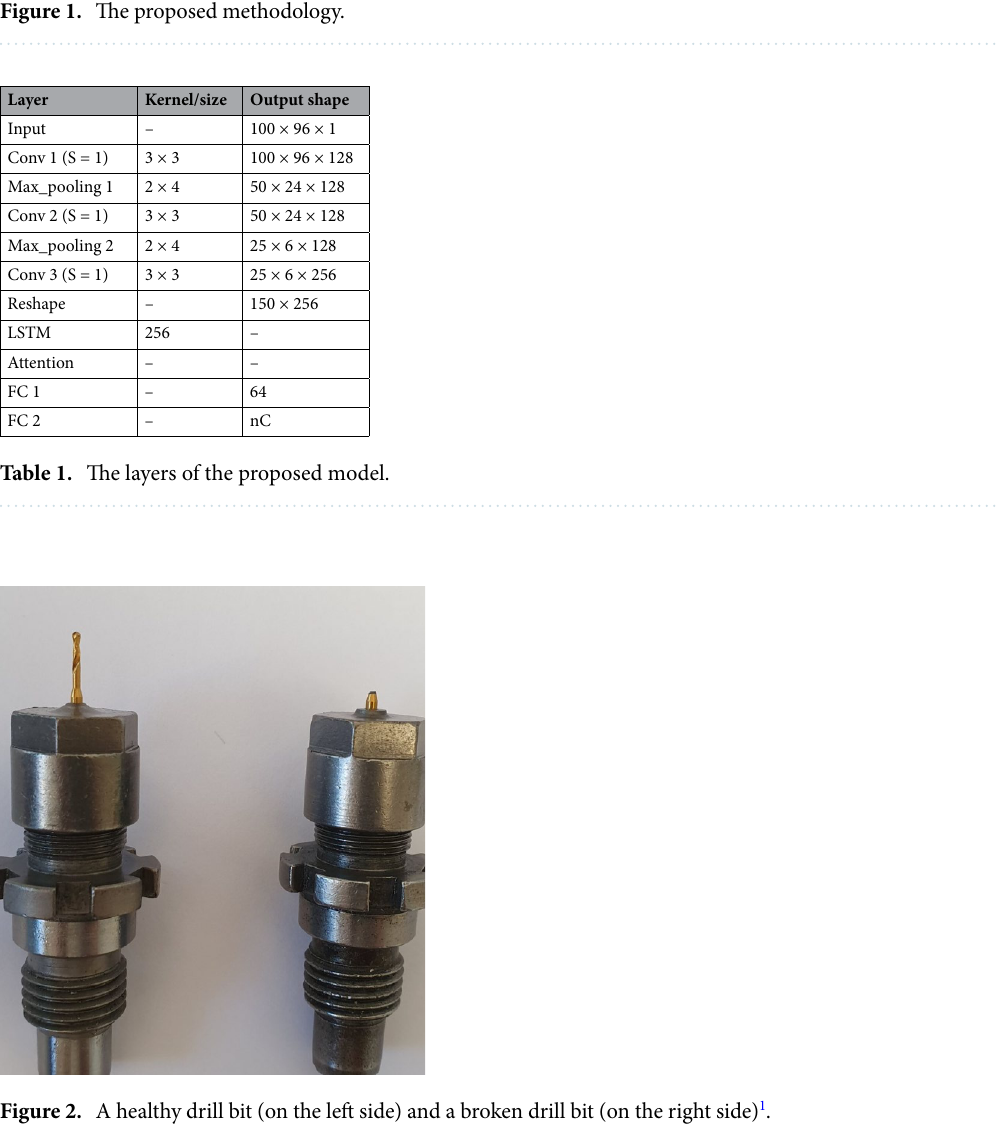
Figure 1. The proposed methodology.